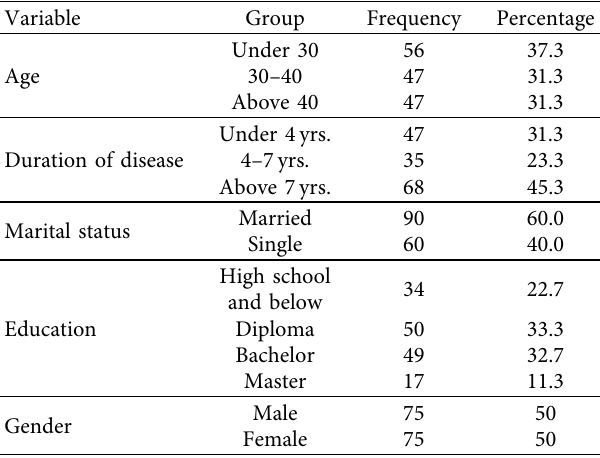
Table 1: The participants’ demographic characteristics ( N �